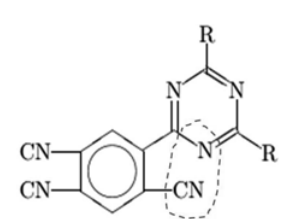
Figure Appendix A.3 . Possible formation of N → N coordinate bond with CN group and (the lone electron pair) on the N from the tri- ple N ring. A coordinate bond on a lone pair of N generates a plus on the N of the triple N ring. One can compare this to the forma- tion of the plusion NH ⊕ 4 or e.g. (CH 3 ) 2 N ⊕ = O. In addition to the internal pi-bond storage of the additional electric charge, a plus charge can be formed with a coordinate bond. Perhaps that such a geometric hiding of the charge will contribute to what is claimed in the paper to be a immunization of Coulomb interaction between NMCZ and TCNB. The three joined TCNB molecules are triple negatively